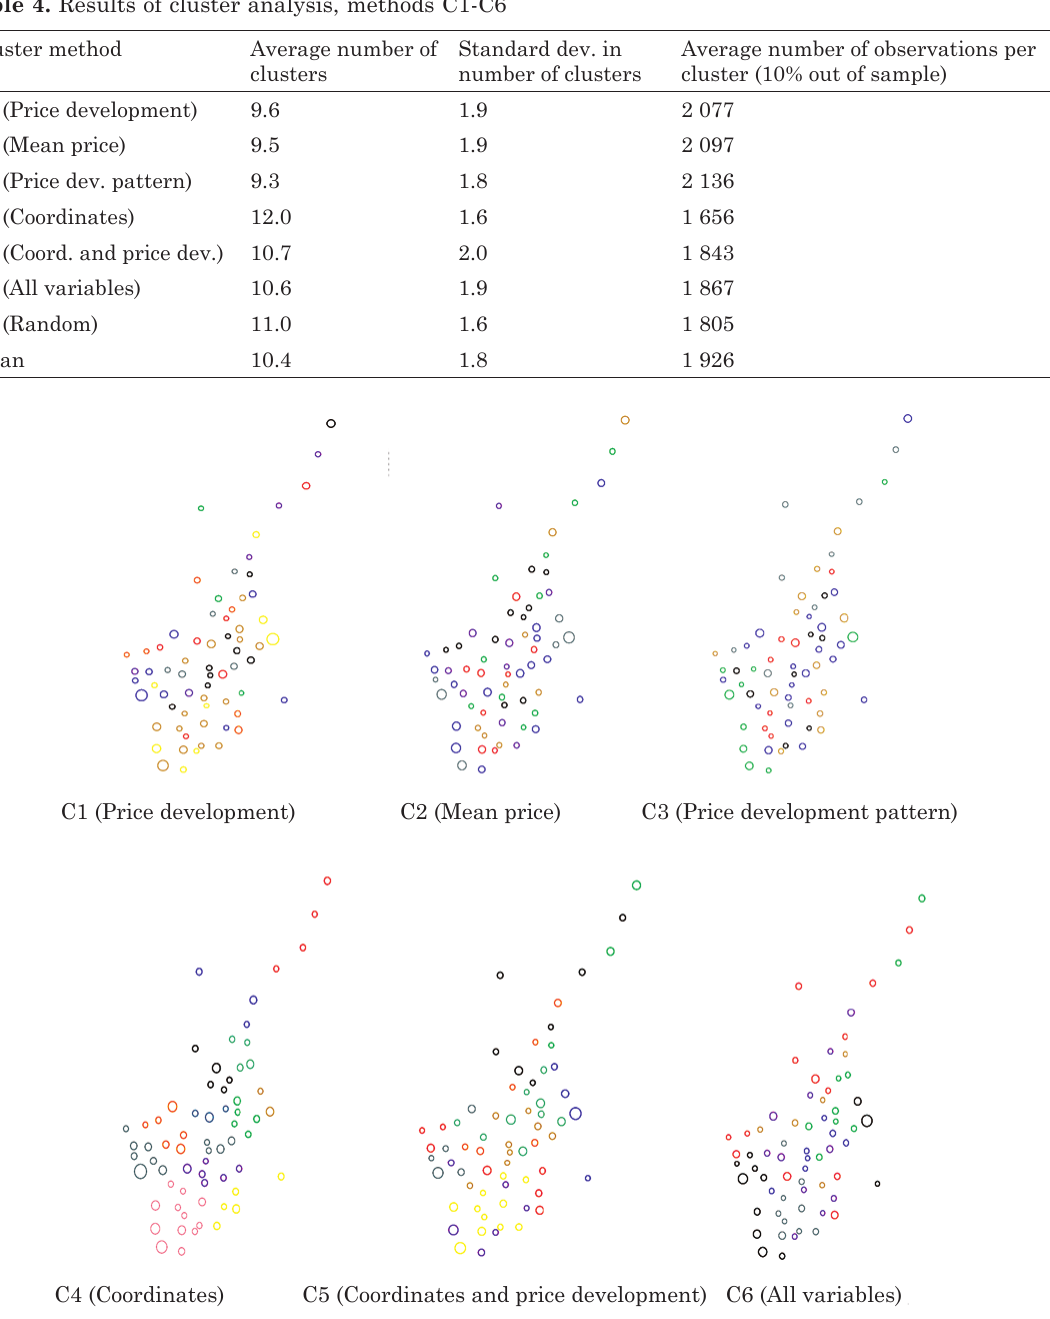
Figure 4. Maps created from clustering methods C1-C6 (cluster variables within parenthesis) clusters based on geographical proximity. It is interesting to see that other clustering com- mands also creates some clusters with nearby regions, the price development pattern (C3) for